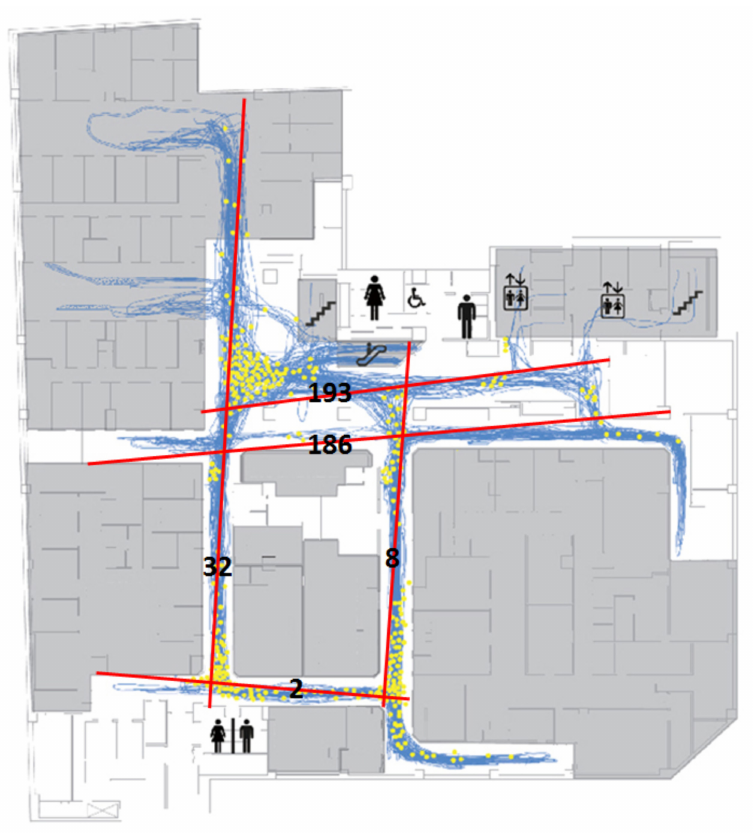
Figure 10. The behavioral annotation diagram and points where participants became lost on the first basement floor of the CCH/CKB